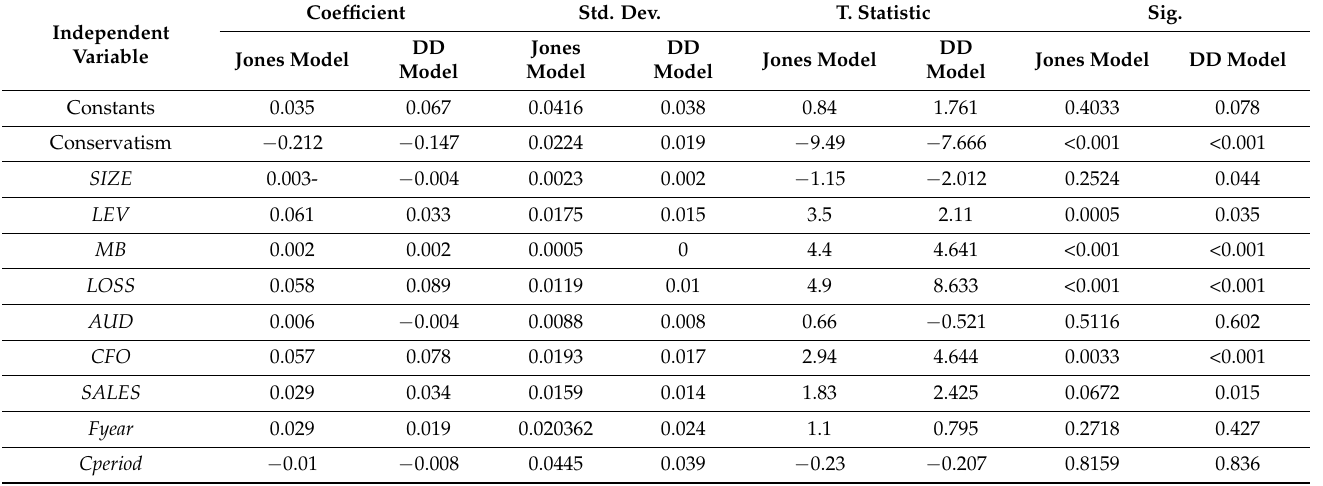
Table 2. The results of the first hypothesis